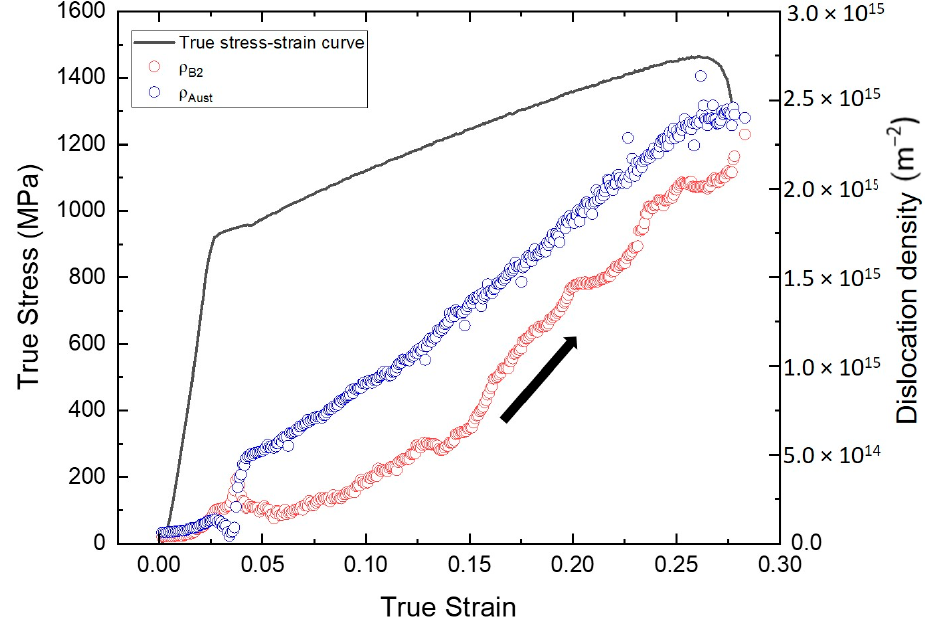
Figure 11. The estimated dislocation densities of austenite phase (blue circle) and B2 phase (red circle) during tensile deformation are plotted as a function of the tensile true strain. The increasing of dislocation accumulation rate in the B2 phase from a tensile strain of 0.13 is indicated by the arrow. The dislocation density can be related to the flow stress, 𝜎 (cid:3007) , according to the Bailey-Hirsh equation [48]: